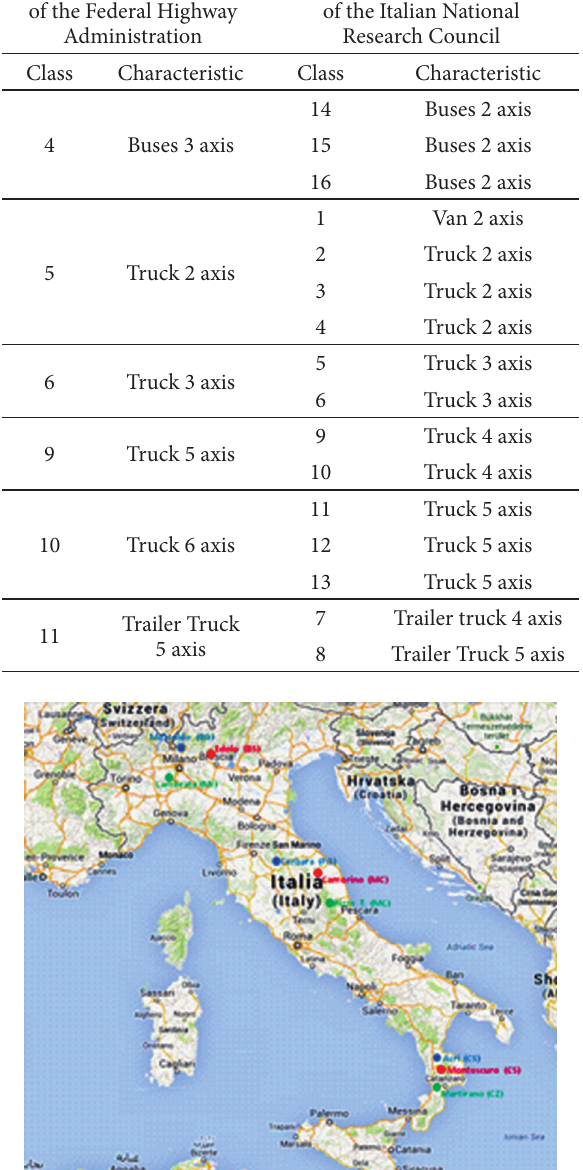
fig. 1. Map of the survey